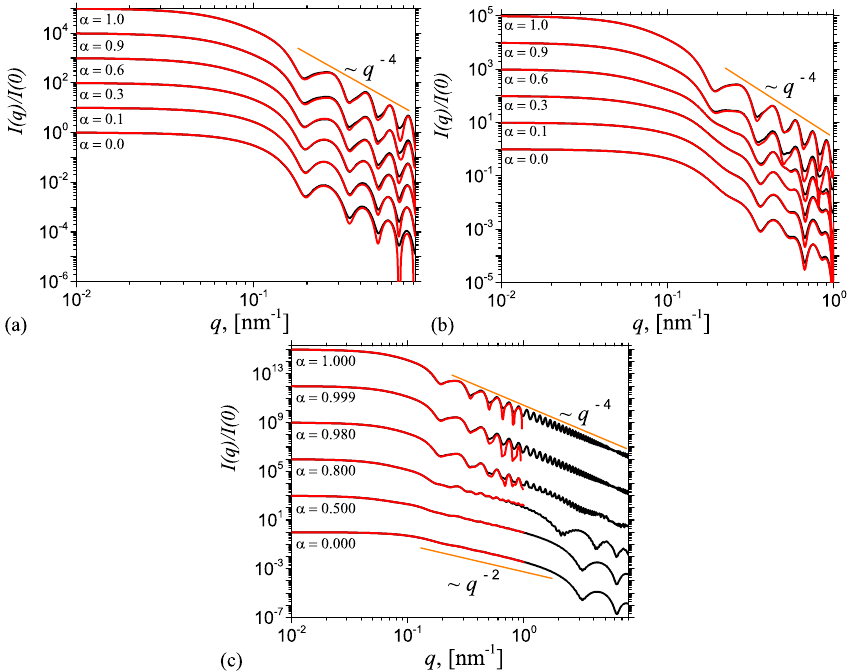
Figure A3. (Color online) Comparison between theoretical curves (black; Equation (19)) and Monte-Carlo simulations (red; Equation (10)) for AnJPs with height 2 L 0 = 80 nm and diameter 2 a = 40 nm, at: ( a ) h = 0 nm; ( b ) h = 20 nm; and ( c ) h = 38 nm, for different values of the contrast parameter α . For clarity, the curves corresponding to α (cid:54) = 0 are shifted vertically by a factor of 10 i ( a , b ) and 10 3 i ( c ), with i = 1, · · · ,5, in increasing order of the values of α